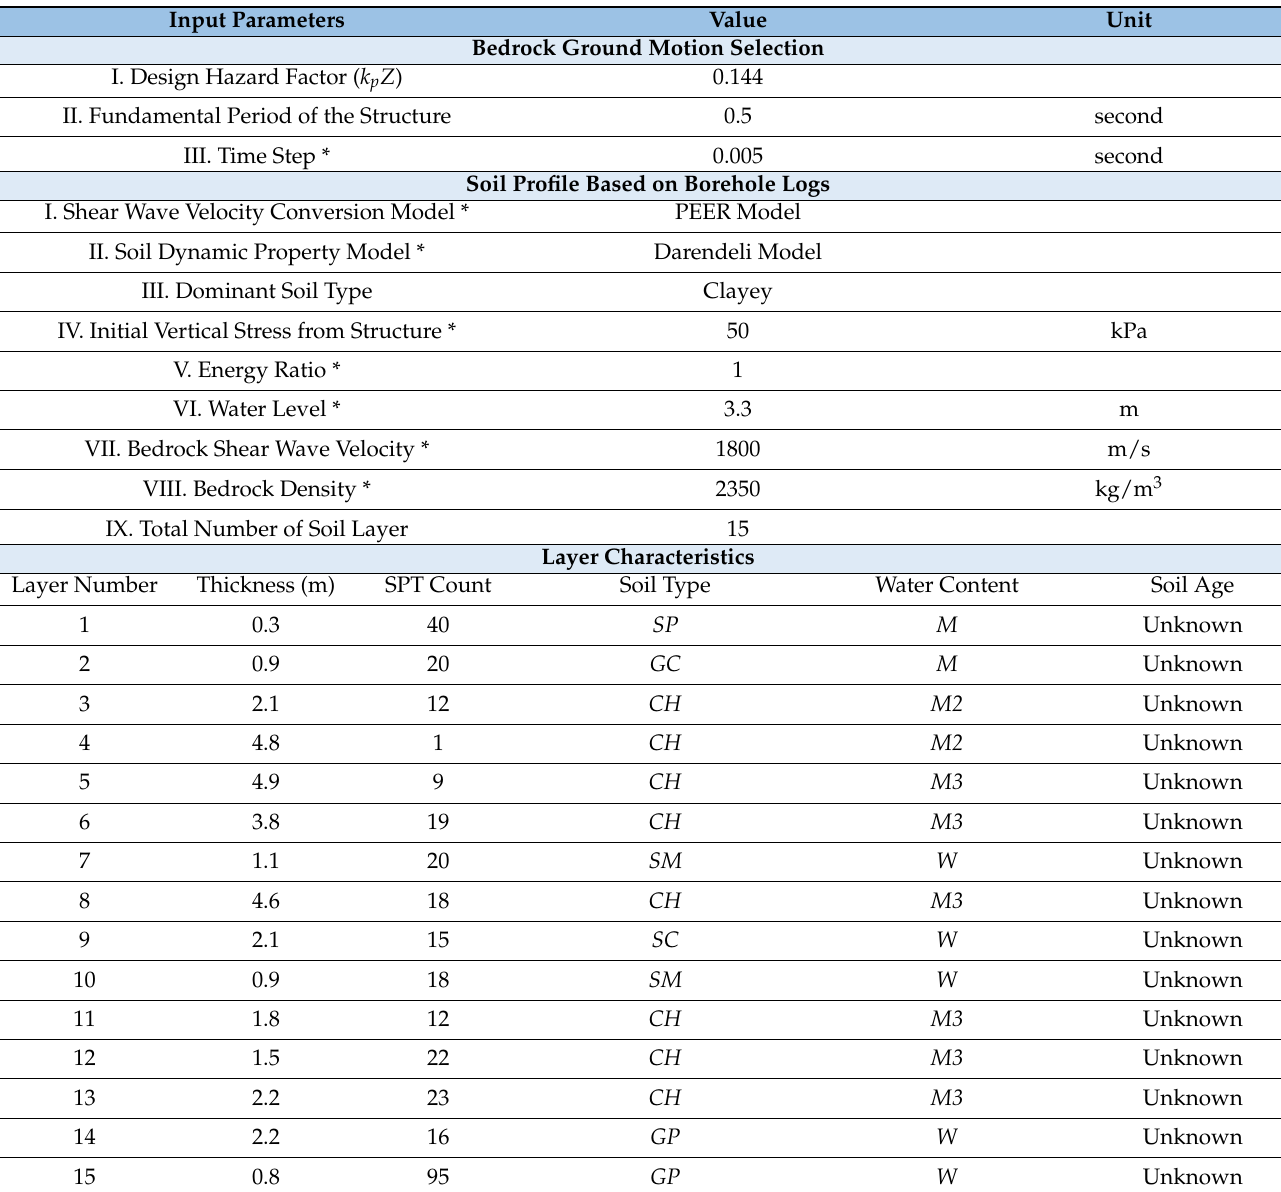
Table 6. Input parameters for the case